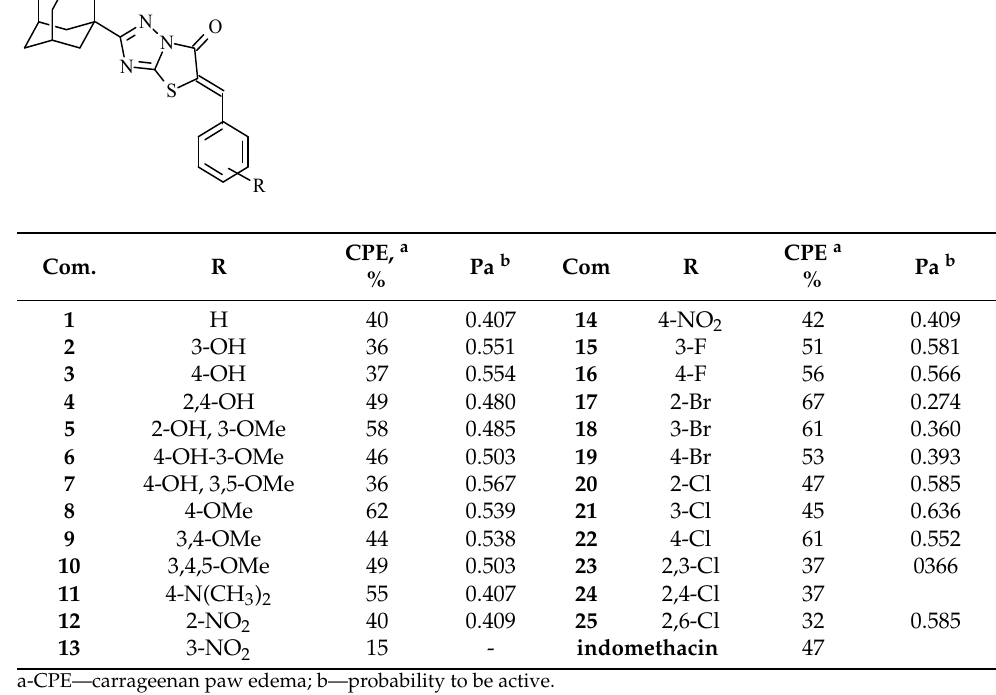
Table 1. Anti-inflammatory activity (CPE% values) of substituted 5-benzyliden-2-adamantylthiazole